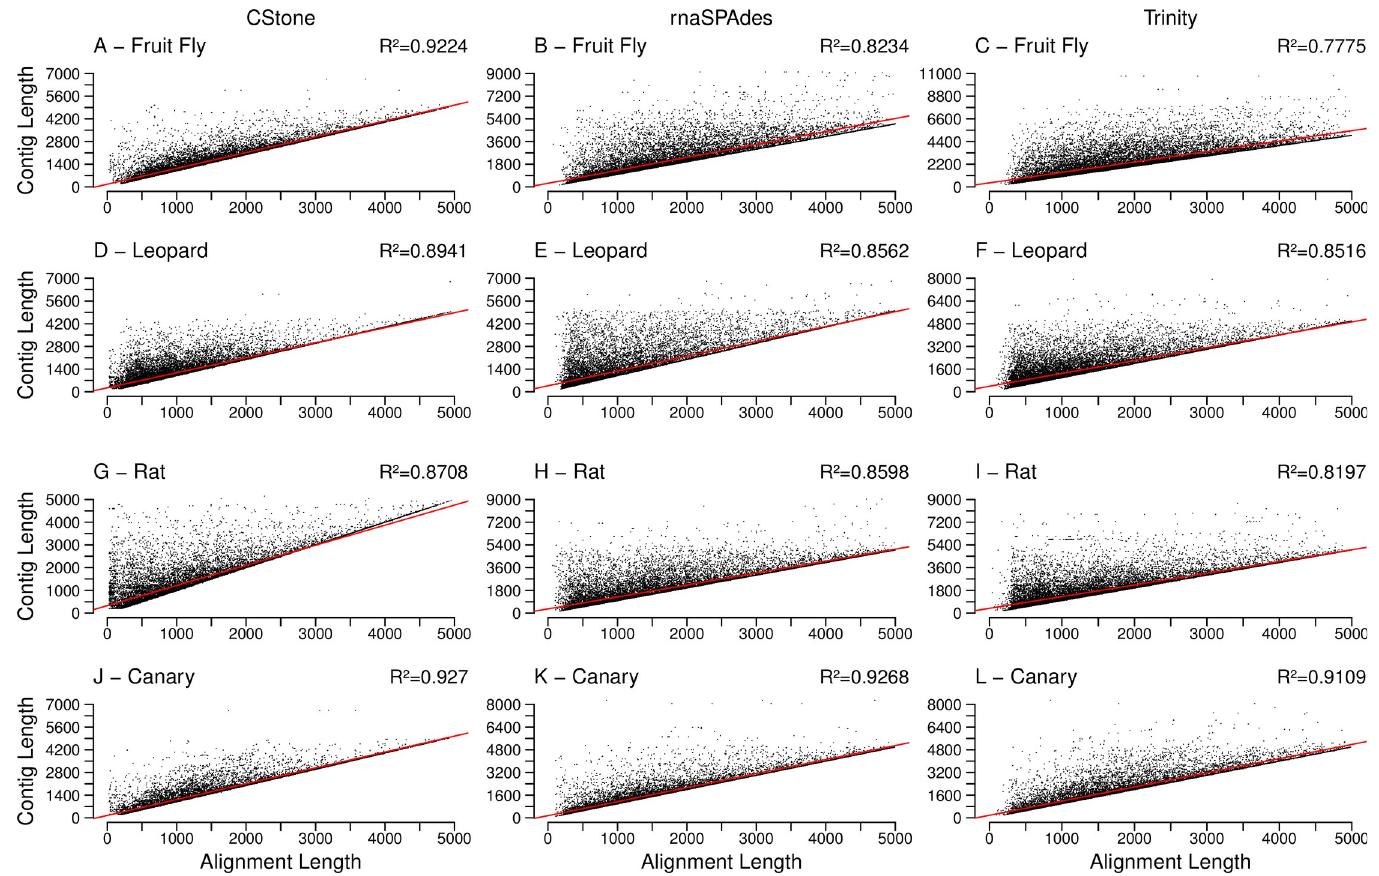
Fig 8. Length of aligned region versus length of contig. R 2 values, located on the top right corners, indicate the correlation between contig lengths and aligned region lengths. The description of the rest of the figure is identical to that of Fig 5.